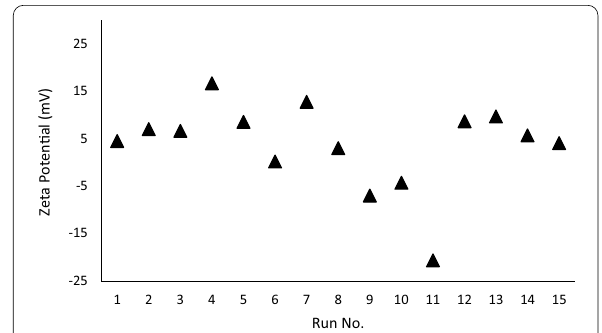
Fig. 2 The zeta-potential of the chemically modified fibers obtained in different experiments suggested by Box–Behnken design